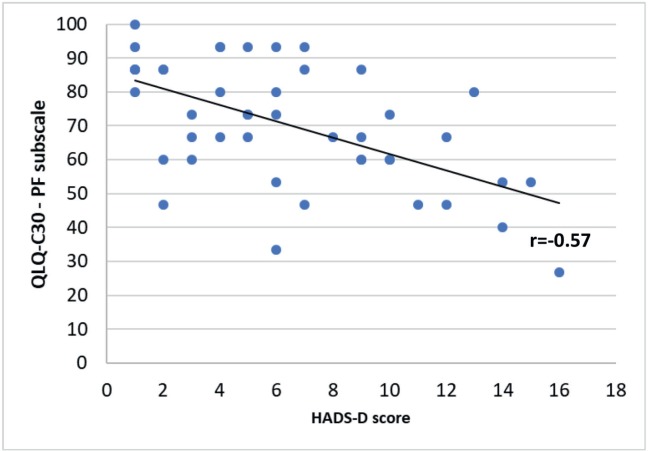
Correlation between HADS-D and the physical functioning (PF) subscale of EORTC QLQ-C30.